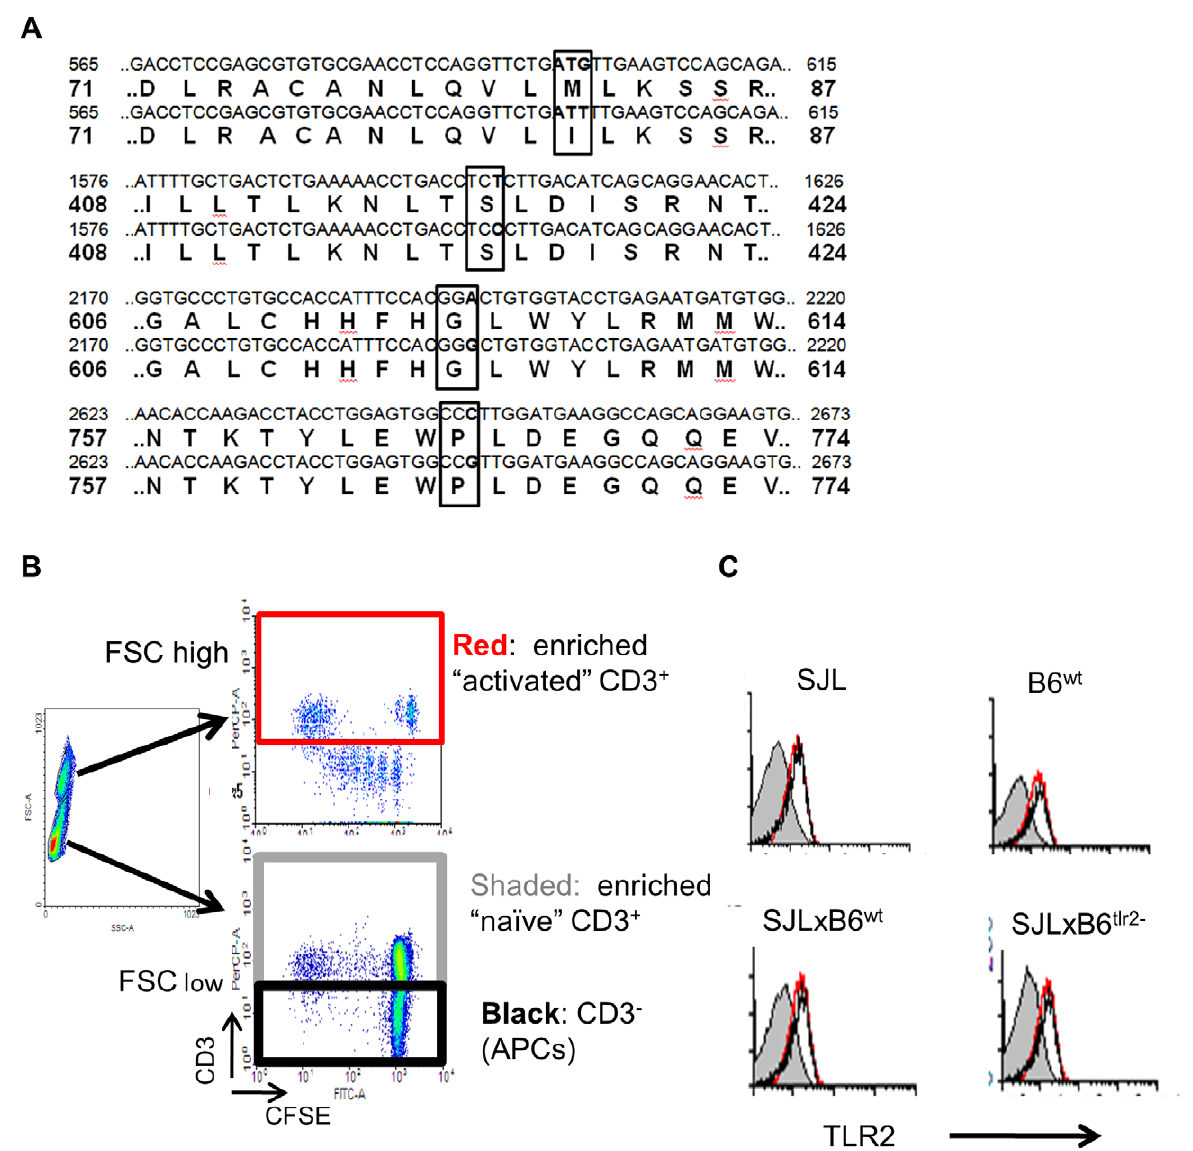
Figure 3. Identification of polymorphisms of TLR2 between SJL and B6 strains and expression of TLR2 on immune cells. A ) Comparison of the sequence of TLR2 of SJL and B6. The non-synonymous and synonymous polymorphisms are boxed. Base (first line) and aminoacid (second line) sequences of B6 and the corresponding sequences (third and fourth lines, respectively) of SJL around the polymorphic residues are reported. B ) Identification of enriched activated T cells, naı¨ve T cells and APC in LN cells by scattering properties. SJL, B6 wt , F1 (SJLxB6 wt ) and F1 (SJLxB6 tlr2 2 ) mice were immunized with IFA containing 50 microgrammes/mouse of M tb .. 8 days later, mice were sacrificed and cells from draining LN were loaded with CFSE and stimulated with PPD. After 3 days, cells were collected and stained with PE-labeled anti-CD3 monoclonal antibody. The colours define cells examined for TLR2 expression in panel C. C ) SJL, B6 wt , F1 (SJLxB6 wt ) and F1 (SJLxB6 tlr2 2 ) mice were immunized with IFA containing 50 microgrammes/mouse of M tb . Eight d later, mice were sacrificed and cells from draining LN were stimulated with PPD. After 3 days, cells were collected and stained with PE-labeled anti-CD3 mAb and with FITC labeled anti-TLR2 mAb. Expression of TLR2 was evaluated on high scattering CD3 + cells (activated T cells, red line), low scattering CD3 + cells (naı¨ve T cells, shaded area) and CD3 2 cells (mostly APC, black line), as shown in B .